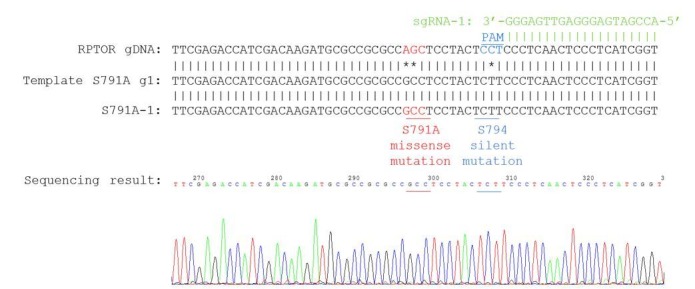
Sequencing chromatogram for knock-in clone S791A-1.